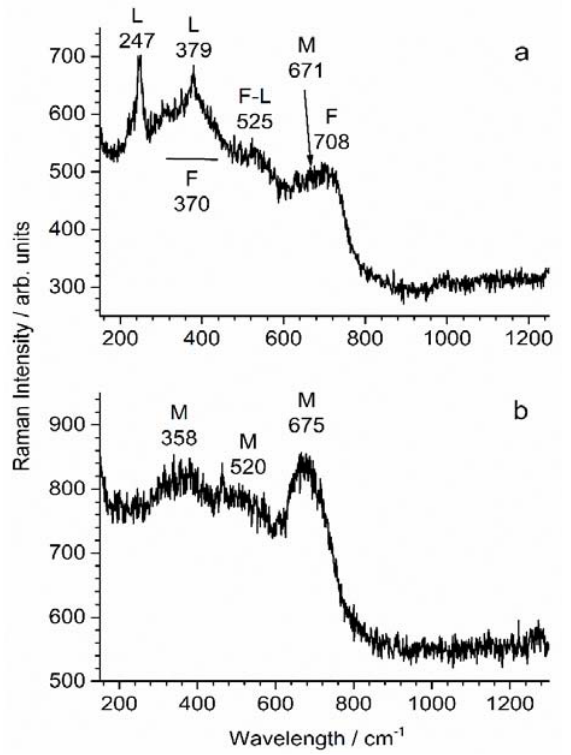
Figure 13. µ -Raman spectroscopy analysis of the surface of coupon WE CP1 ; G = goethite, Figure 13. μ‐ Raman spectroscopy analysis of the surface of coupon WE CP1 ; G = goethite, M = mag ‐ M = magnetite/maghemite. See text for the interpretation of spectra ( a , b netite/maghemite. See text for the interpretation of spectra ( a ) and ( b ).